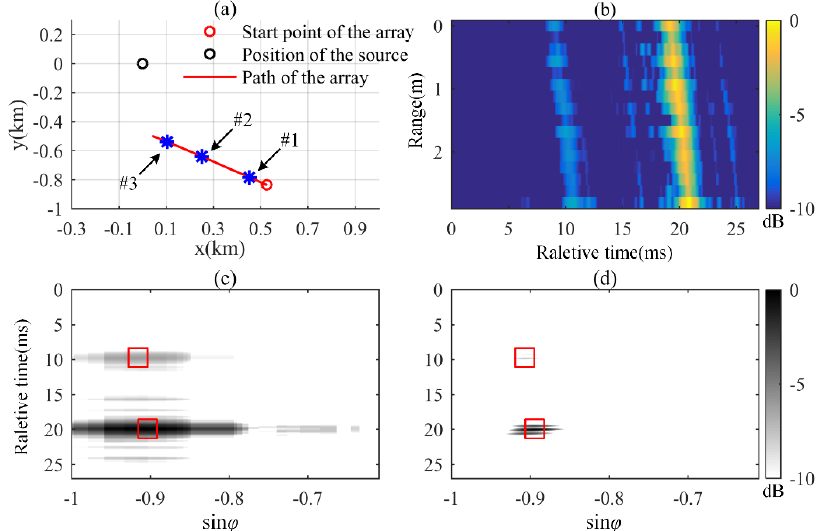
Figure 3. (Color online). ( a ) Positions of the array and source in the experiment. ( b ) Green’s function obtained with blind deconvolution at Position #1. ( c ) Beam-time migration obtained using the reference method. ( d ) Beam-time migration obtained using the proposed method.